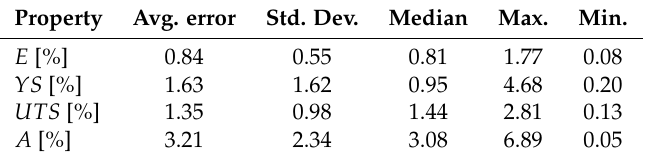
Table 8. Prediction error for Al 2024-T4 (as %).